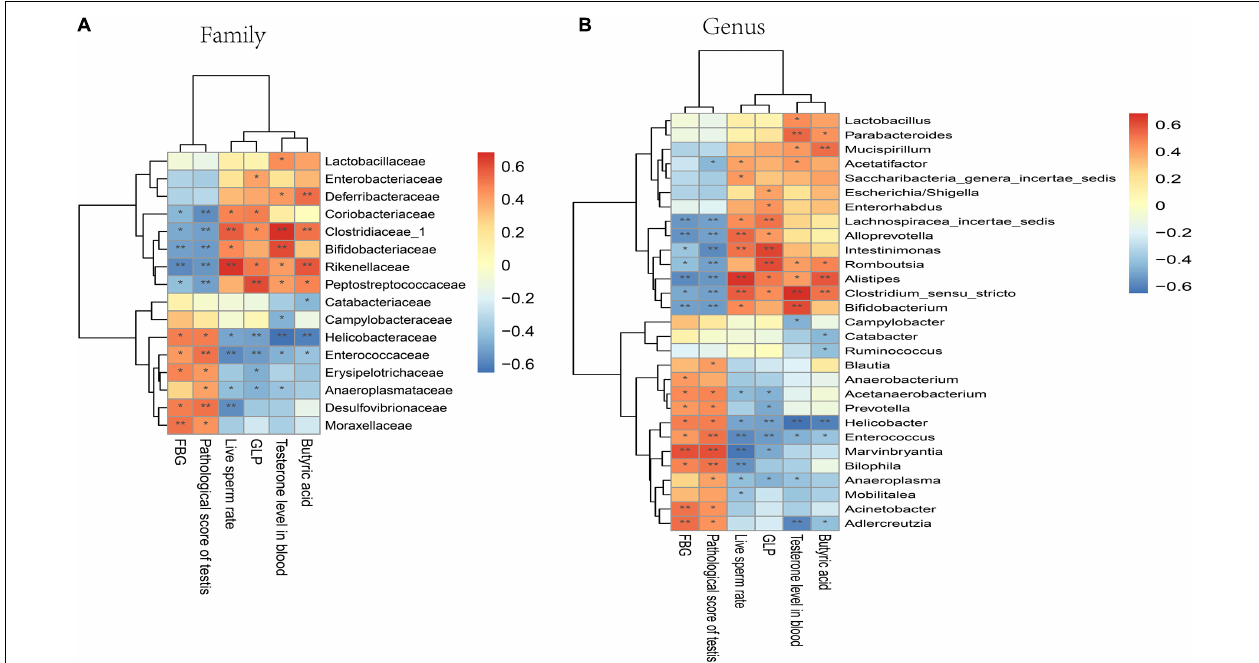
FIGURE 8 | Correlation of GM with FBG, sperm damage indicators, butyric acid, and GLP in mice. (A) Correlation analysis at the family level. (B) Correlation analysis at the genus level. Significant correlations were noted using adjusted. * P < 0.05; ** P <